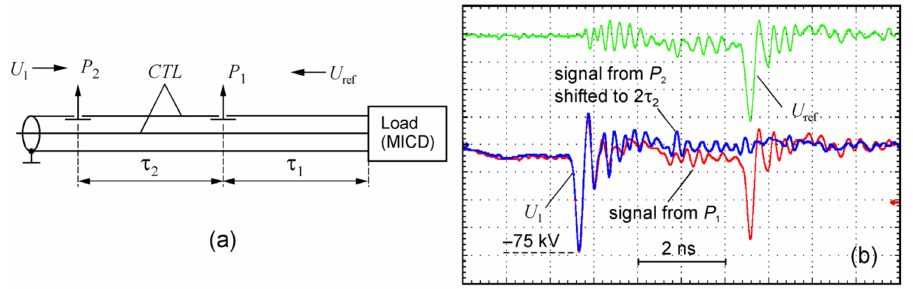
Figure 2. ( a ) DTDR signal acquisition circuit and setting of the signals ( b ) used to separate U ref from the noise on the U 1 signal tail and to measure the delay time τ 1 of the load reflection in no-load